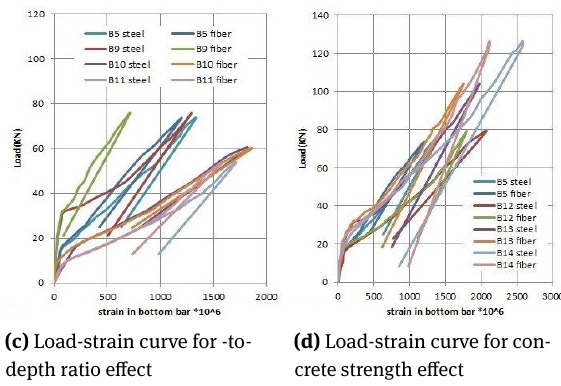
Figure 6: Load-strain curve at mid-bottom steel